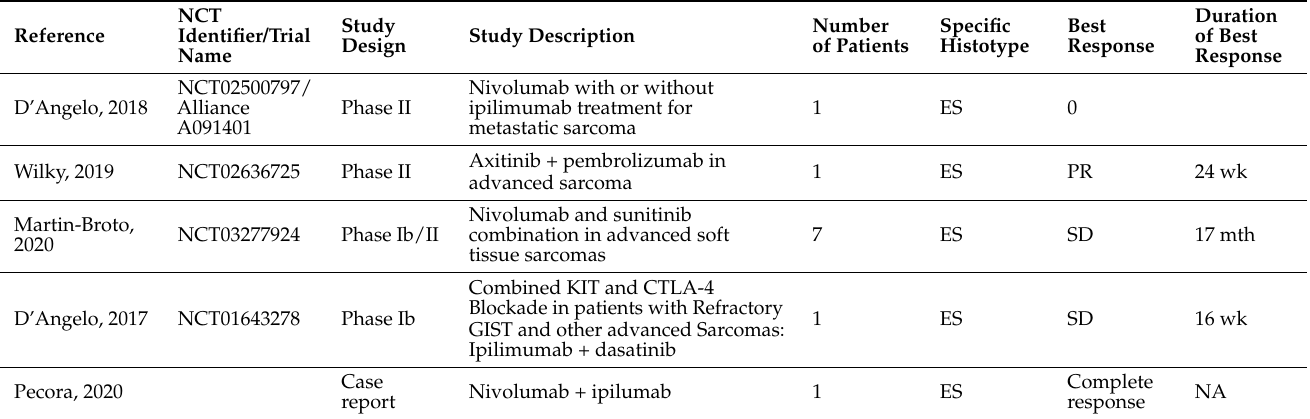
Table 3. Results of clinical studies evaluating ICI therapy in combination in SMARCB1-deficient